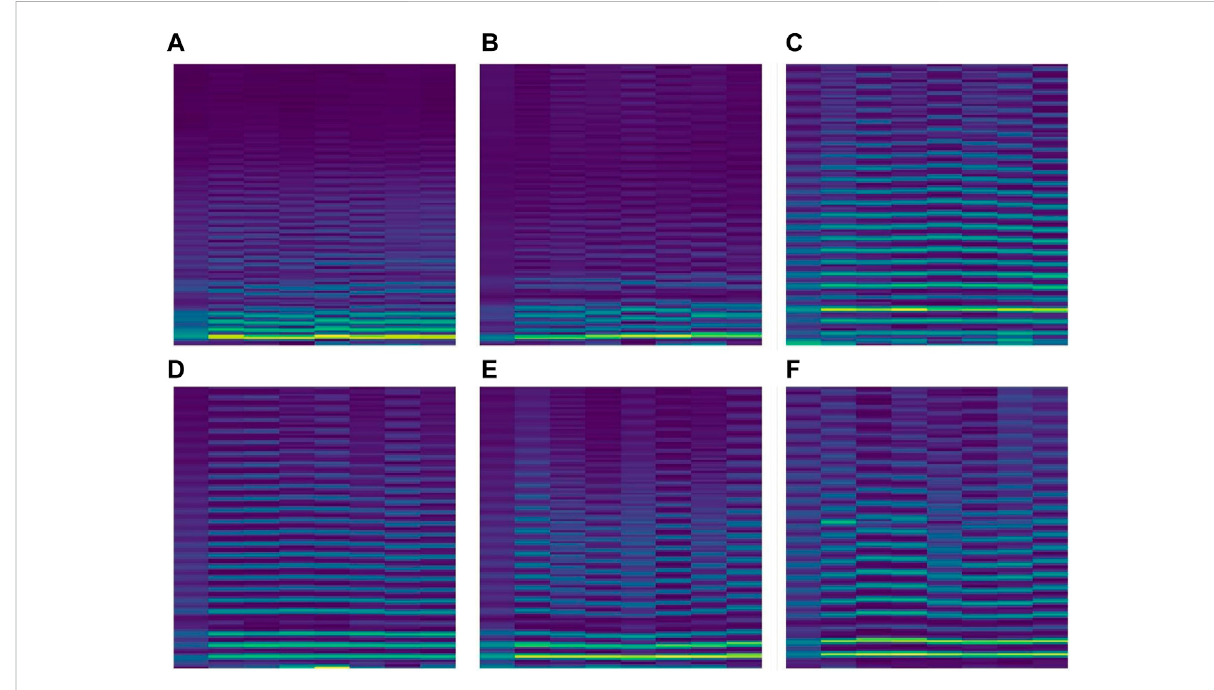
FIGURE 6 ECG spectrograms after STFT processing: (A) lying in bed, (B) sitting in an armchair, (C) walking at a constant speed, (D) pedaling a stationary bicycle, (E) bicycle stress test, (F) Bruce protocol treadmill stress test.